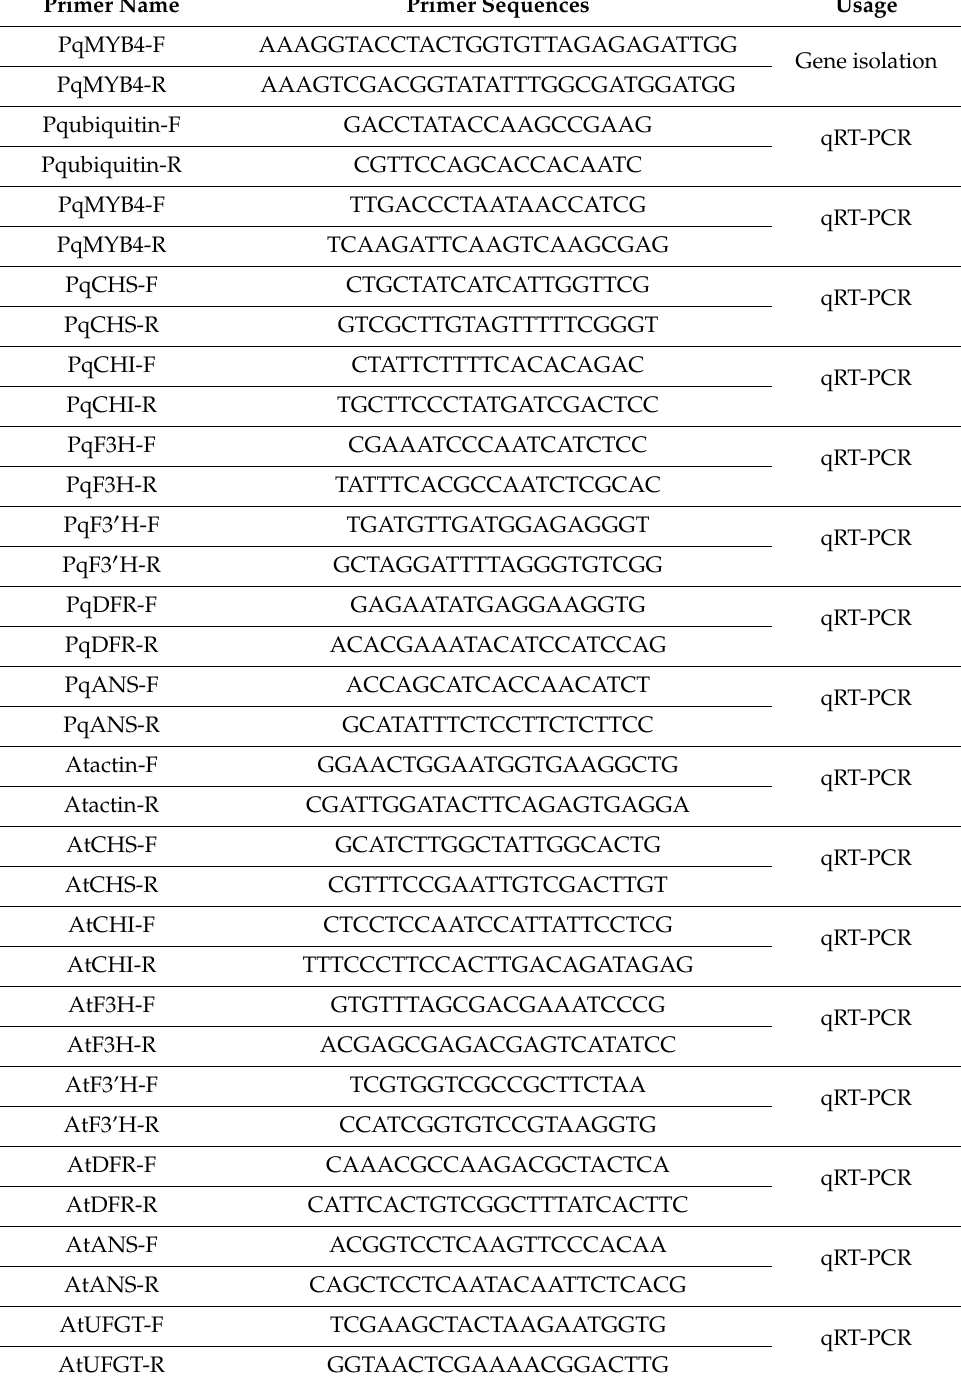
Table 1. Gene specific primers used for qRT-PCR analysis and gene